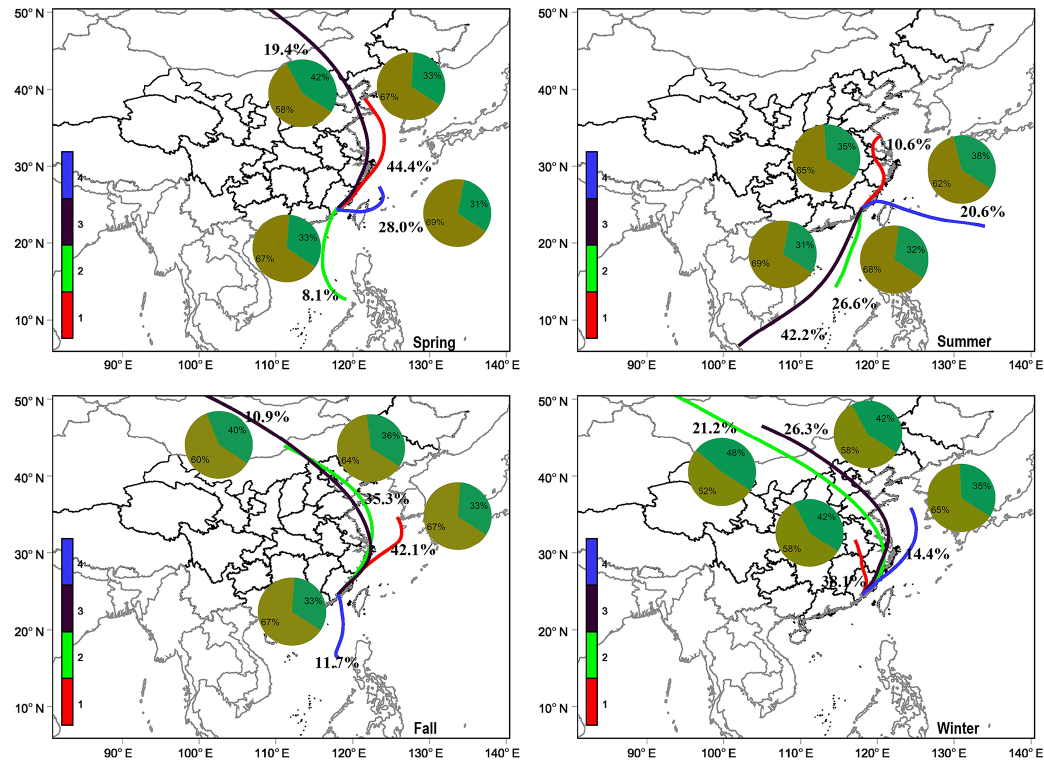
Figure 7. Seasonal cluster mean of 5d backward trajectories at 500m with the corresponding trajectory percentages and BC bb contributions in Xiamen. The pie charts represent relative contributions of BC ff (dark yellow) and BC bb (olive green). The four-colored legend indicates the four different trajectory clusters. The percentages along the trajectories represent the percentage of each cluster in all trajectories.